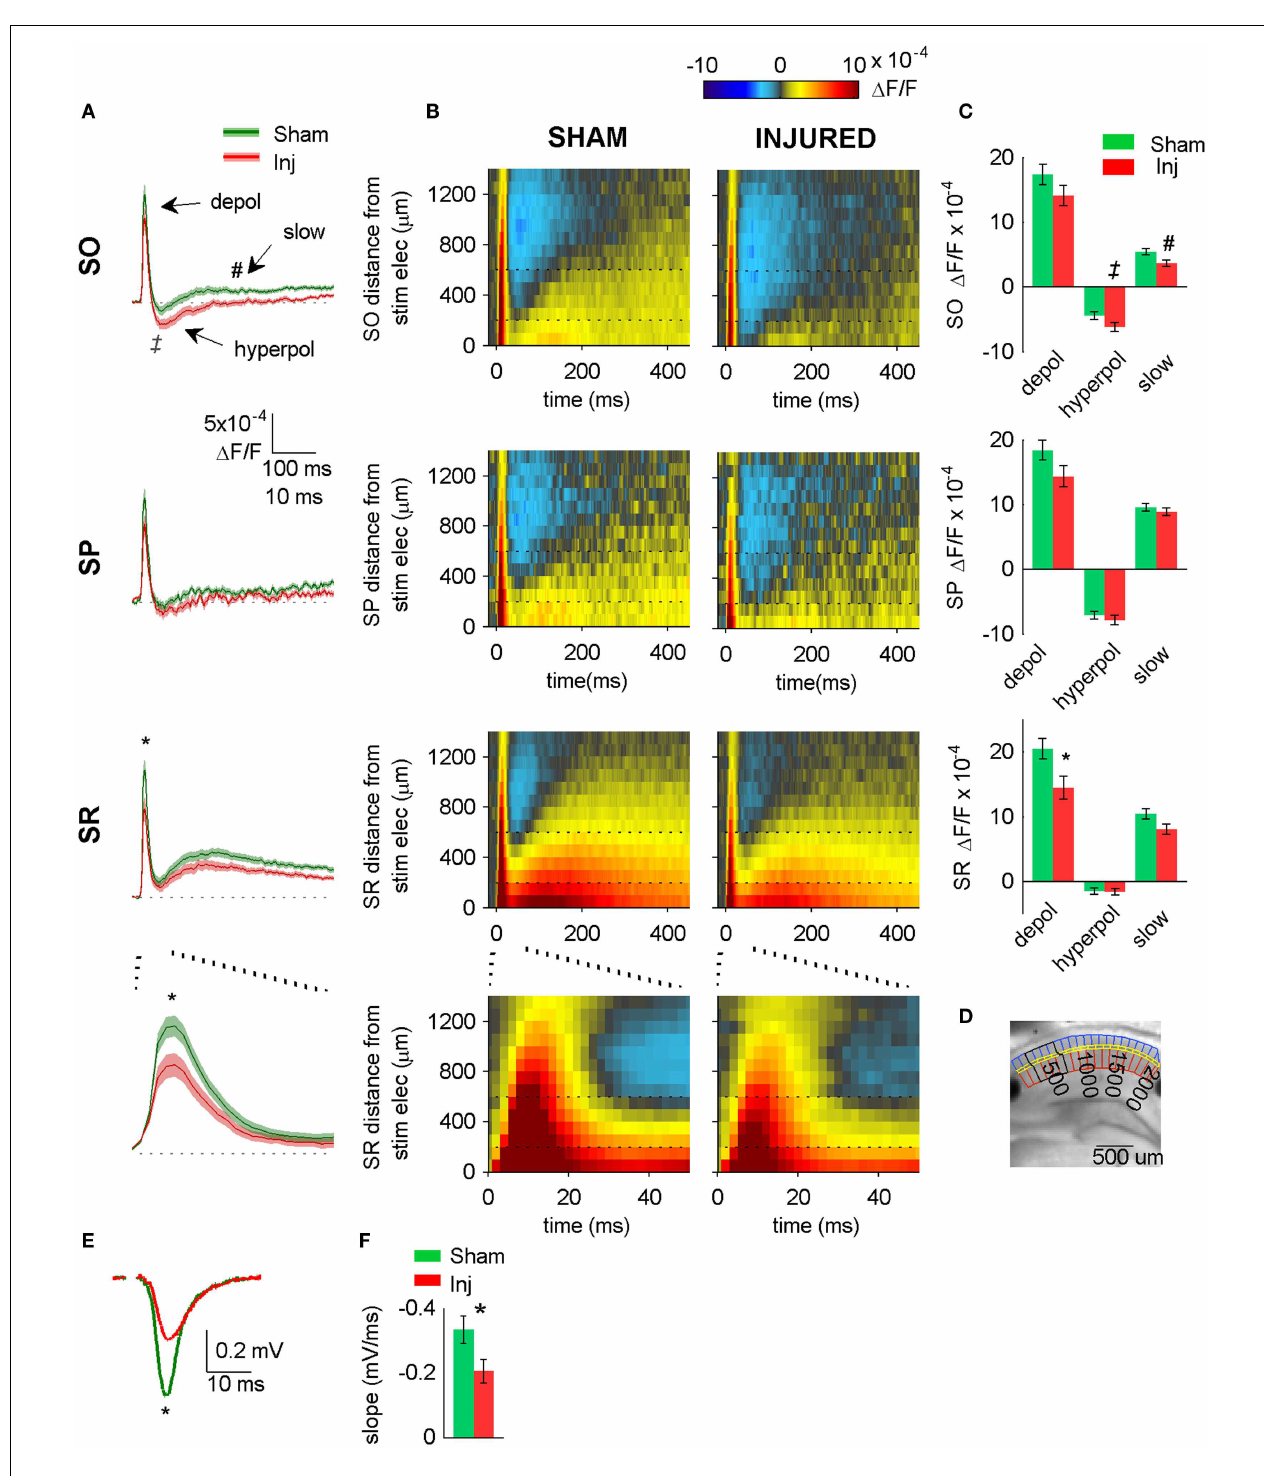
expanded time scale. (B) Group average raster representation of sham ( n = 25) and injured ( n = 22)VSD responses. Each point in the raster shows the average fluorescence signal, ∆ F/F, for the segment at the indicated distance from stimulating electrode, and at the indicated time. A row shows all time points for a given segment; a column shows all segments at a